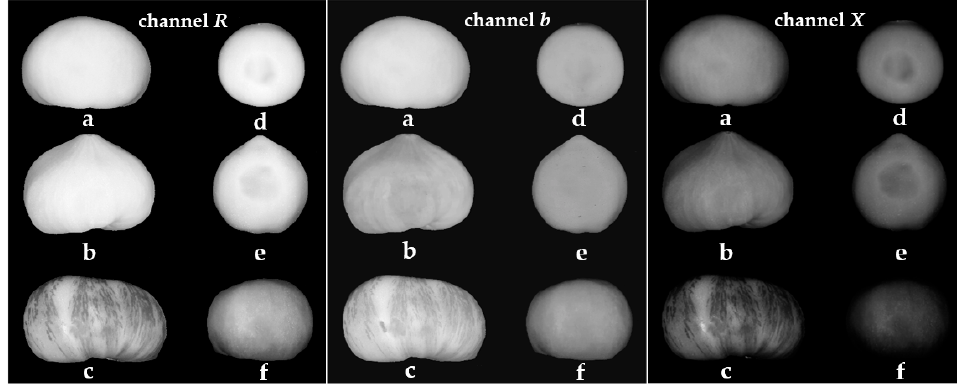
Figure 2. The images from selected color channels of tomato ‘O ż arowski’ ( a ), ‘Marvel Striped’ ( b ), ‘Green Zebra’ ( c ), Sandoline F1 ( d ), Cupidissimo F1 ( e ), and Sacher F1 ( f ).